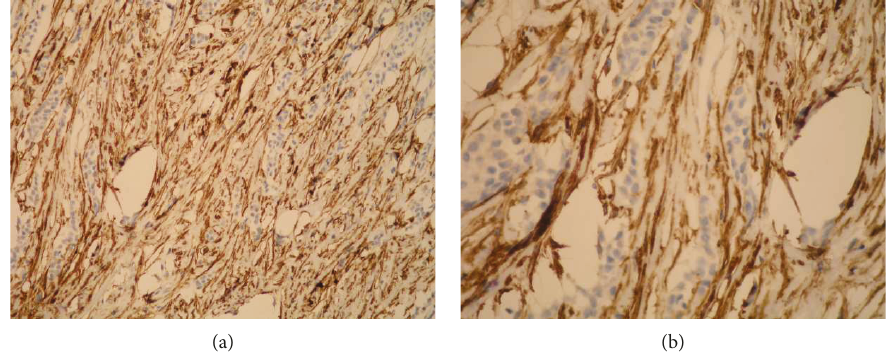
Figure 4: Strong stromal Sdc1 expression in the ILC (the same slide, IHC; × 200 for (a) and × 400 for (b)).